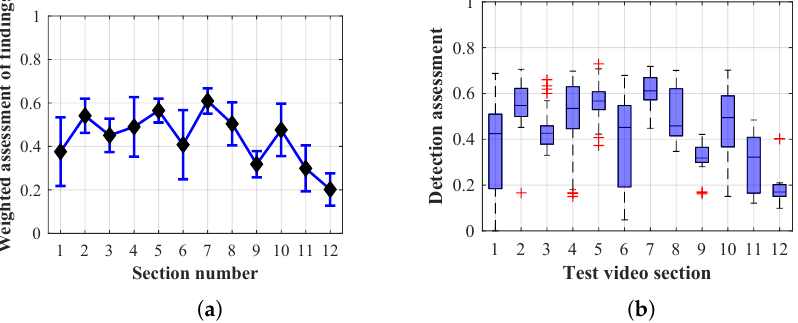
Figure 46. Results of Method 3 with a lifespan of 12 frames. ( a ) the weighted average rating with the average mean absolute error of the weighted rating and ( b ) boxplots of the distribution of the statistical sets of the results of the individual sections evaluated indicating: minimum, 1st quartile, median, 3rd quartile, maximum.